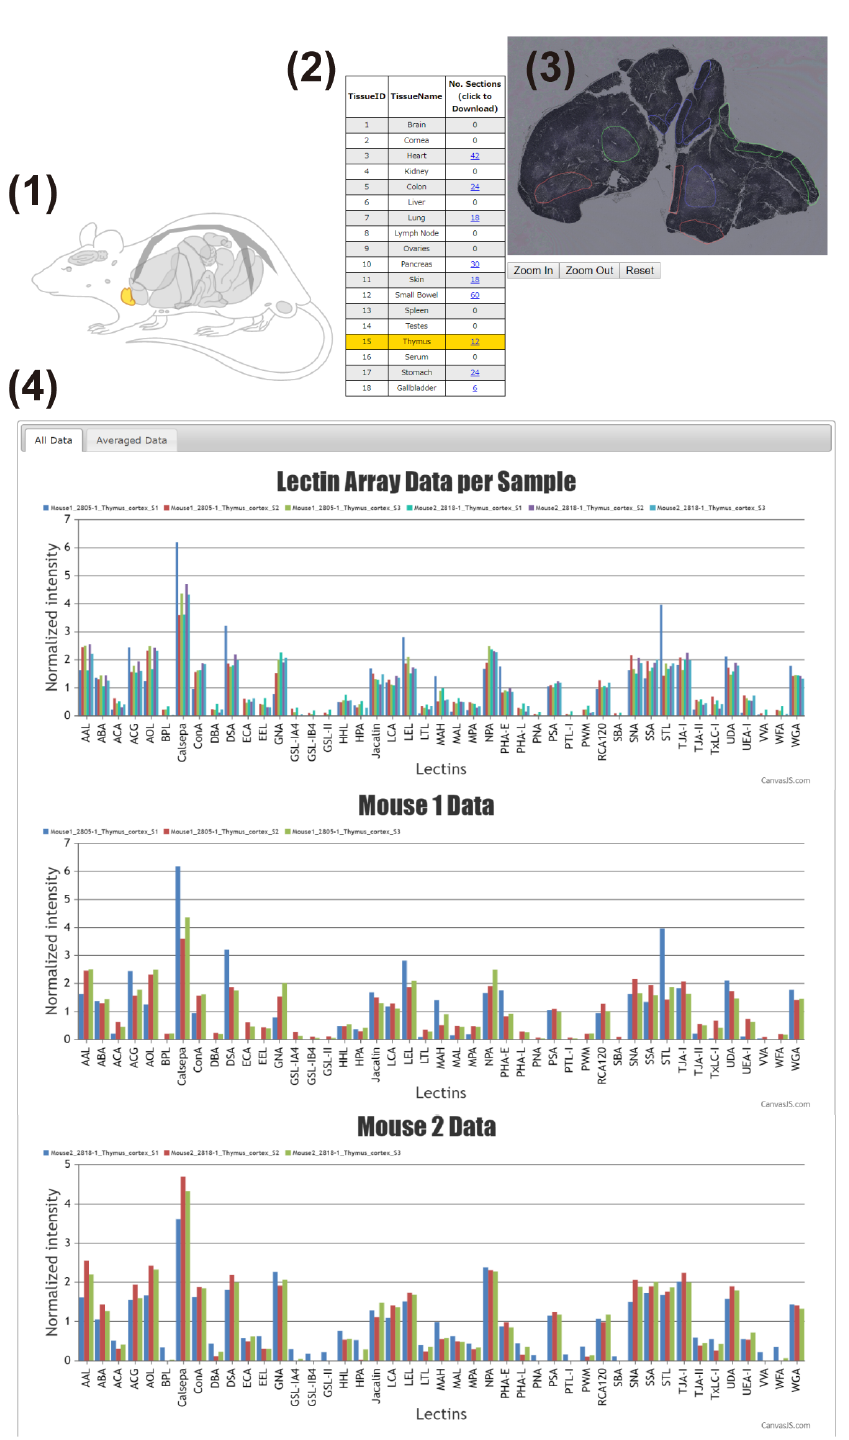
Figure 2. The main interface of the LM-GlycomeAtlas. The display image for the thymic cortex is shown. The main display consists of four main contents: ( 1 ) mouse whole-body diagram, ( 2 ) list of tissues, ( 3 ) representative image of the whole section, and ( 4 ) graphs of the glycomic profiles.